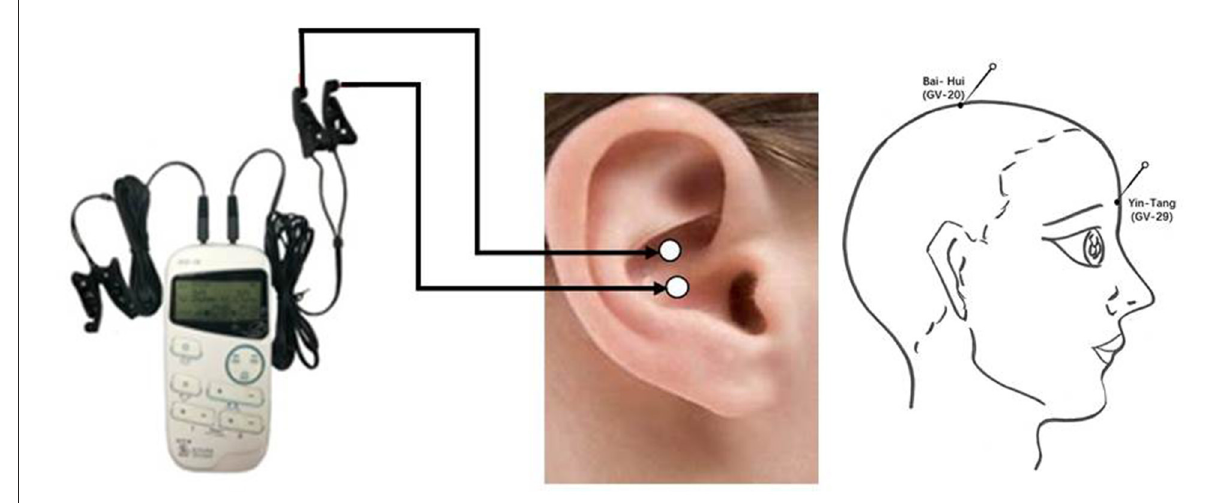
FIGURE1 Location of acupuncture and taVNS. taVNS, transcutaneous auricular vagus nerve stimulation.